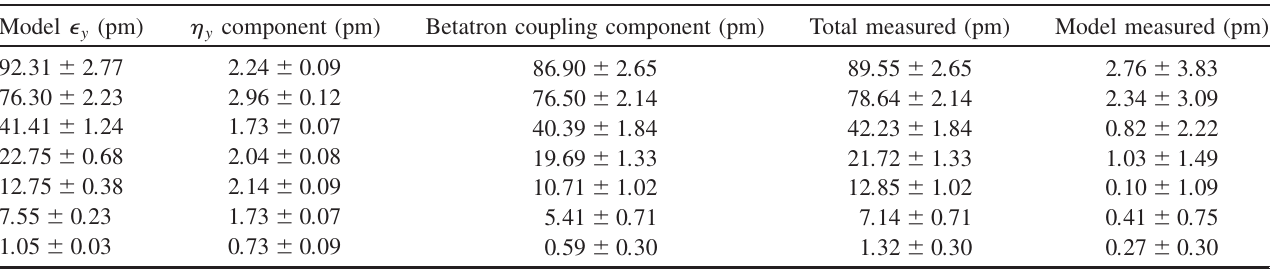
TABLE IV. Comparison of calibrated model predictions with vertical dispersion and betatron coupling measurements. (pm) Betatron coupling component (pm) Total measured (pm) Model measured Model (cid:1) y